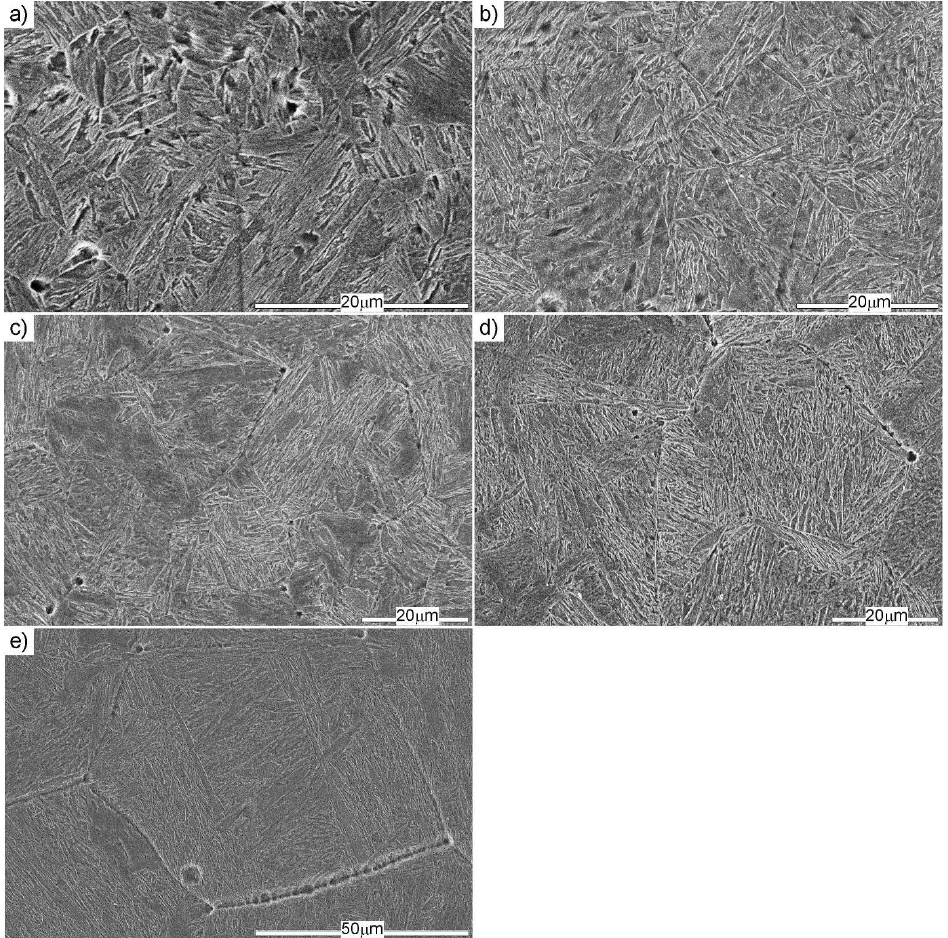
Figure 8. Micrographs showing martensitic packets in the Hardox 450 steel in the as-received state and under different annealing conditions: ( a ) in the as-received state; ( b ) 900 ◦ C, 20 min; ( c ) 1000 ◦ C, 20 min; ( d ) 1100 ◦ C, 20 min; ( e ) 1200 ◦ C, 20 min. Etched state, SEM.